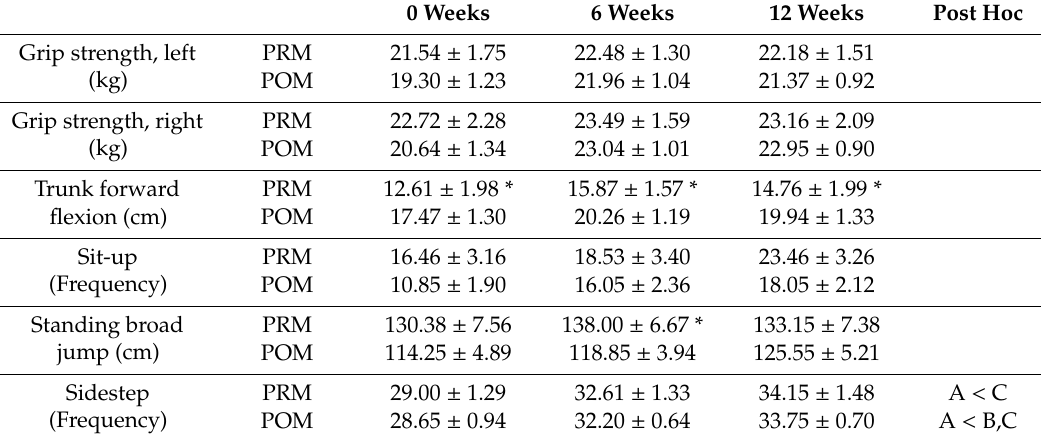
Table 4. Change of basal physical fitness after exercise program.